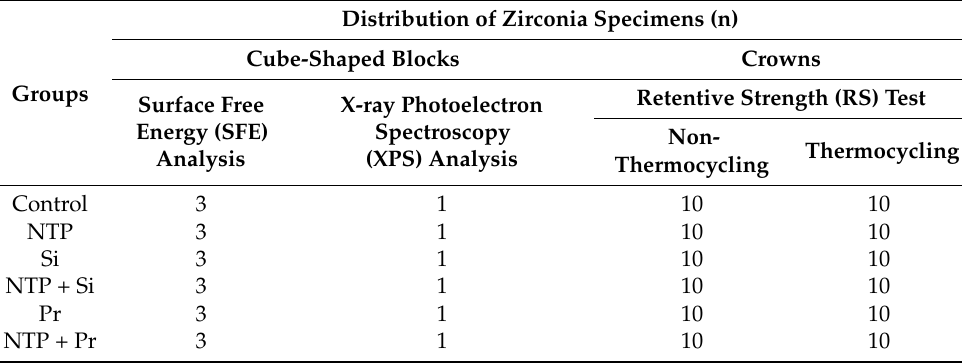
Figure 3. Flowchart of the surface treatment process for zirconia specimens. Table 1. Distribution of zirconia specimens for the entire experimental group. Control, no treatment. NTP, non-thermal atmospheric pressure plasma. Si, Silane. NTP + Si, NTP followed by Silane. Pr, Z-Prime Plus. NTP + Pr, NTP followed by Z-Prime Plus.